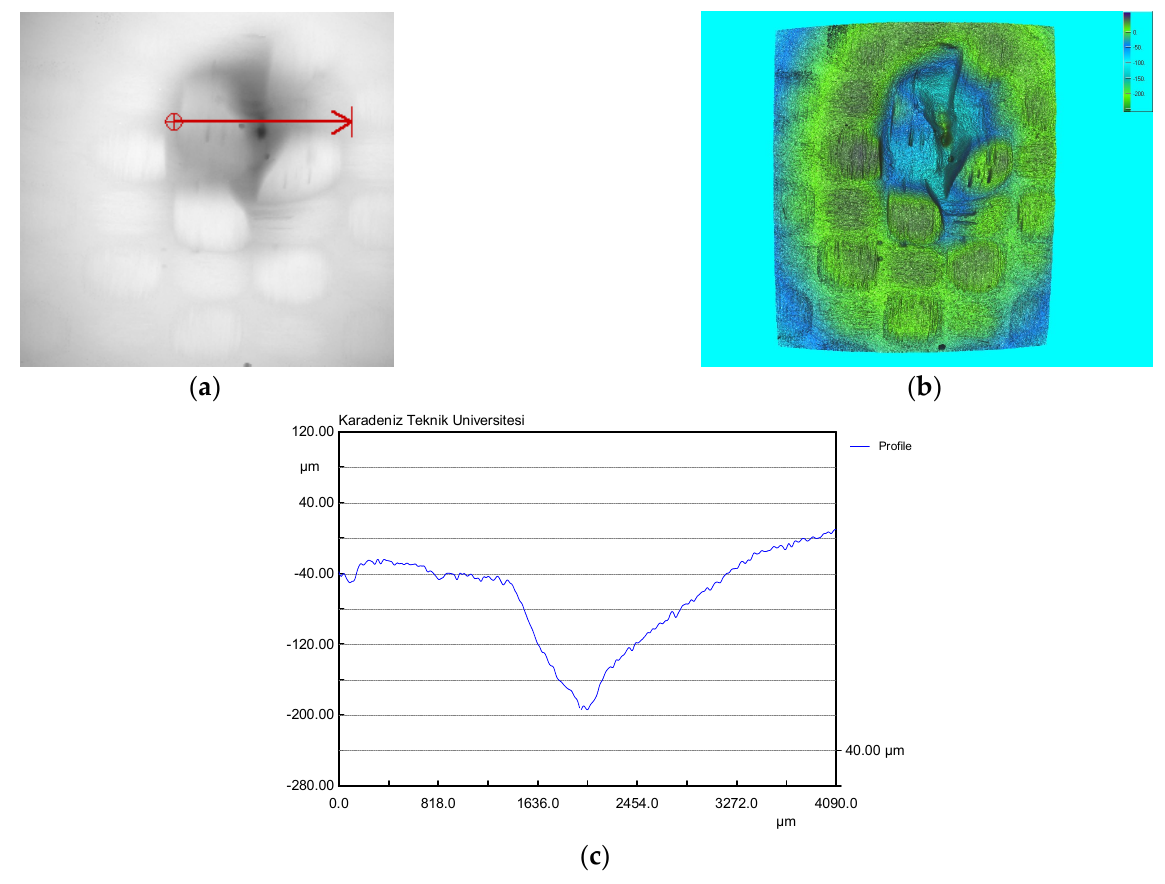
Figure 7. Surface of the eroded sample (Tow = 10k, Angle = 90 degrees, Velocity = 129 m/s), surface topography: ( a ) microscopic view, ( b ) 3D surface profilometer image, and ( c ) surface profile.